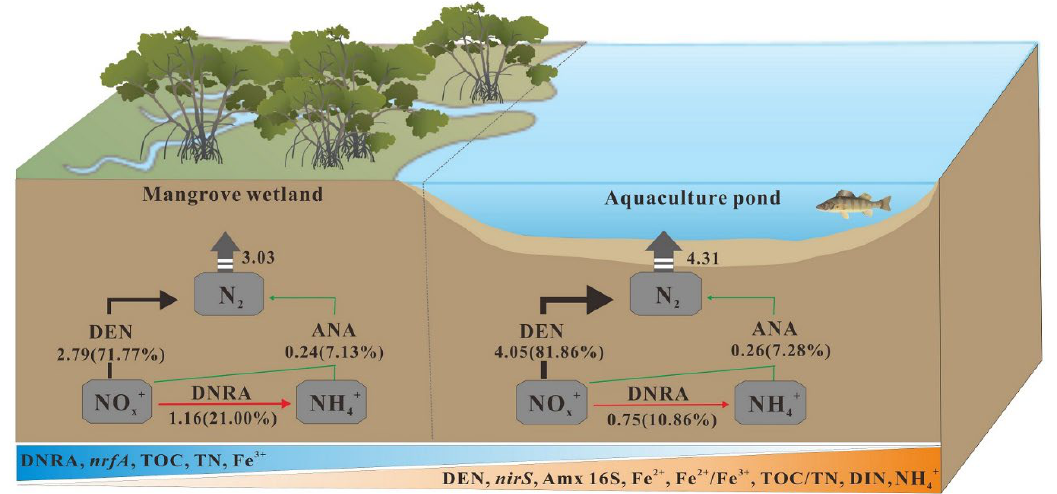
Figure 4. A conceptual map of the controlling factors on sediment NO x − reduction processes in the mangroves and aquaculture sediment cores. DEN and ANA mean denitrification and anammox rates. The unit of denitrification, anammox, and DNRA rates was ng N g − 1 h − 1 .